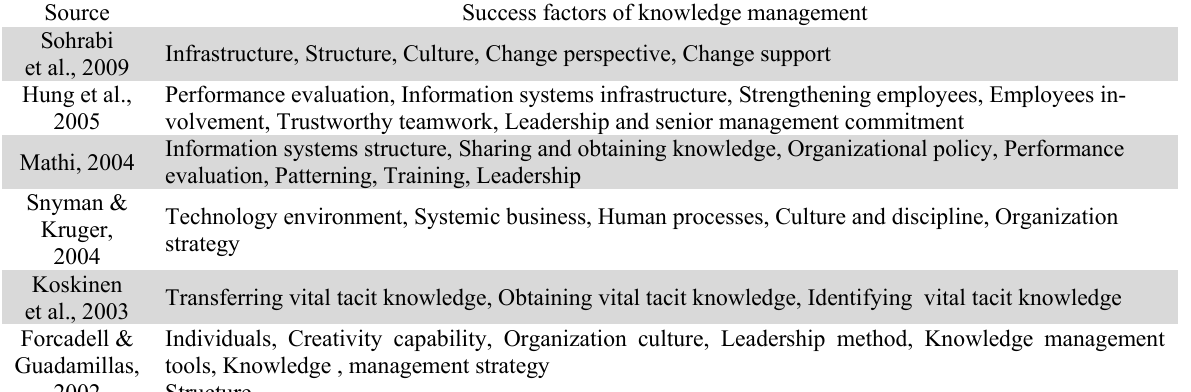
Success factors of knowledge management from the viewpoint of experts Source